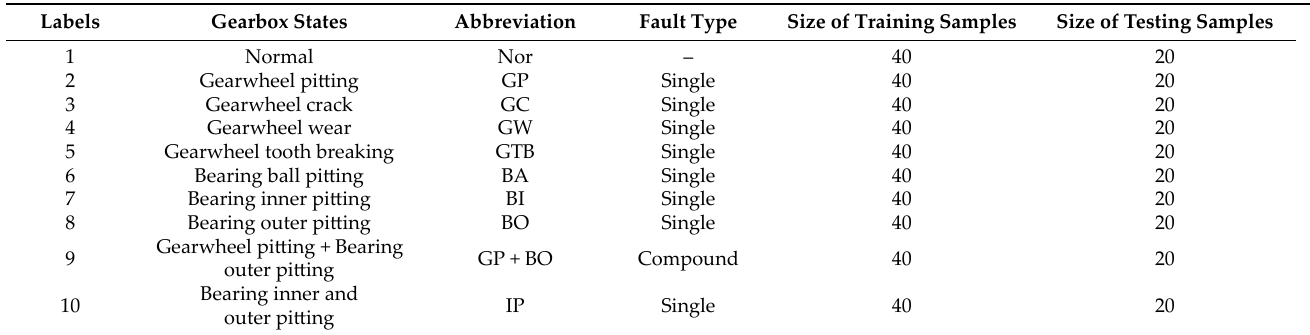
Table 7. The detailed fault information of gearbox components.